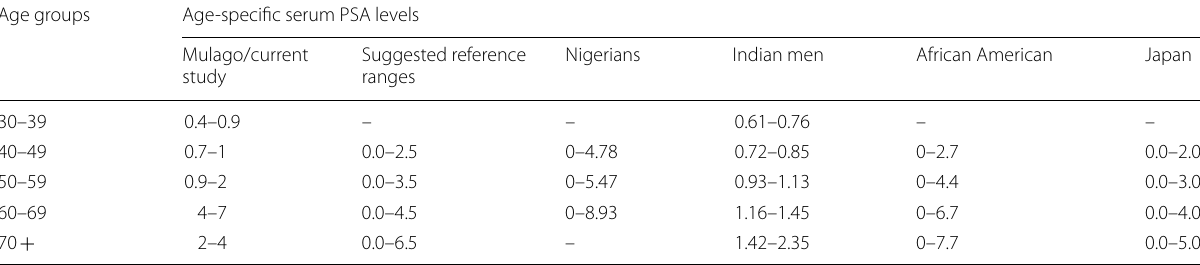
Table 4 Comparison with published age-specific reference ranges Age